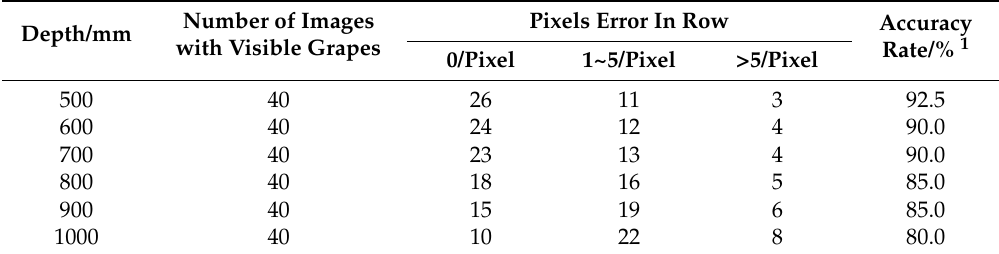
Table 4. Accuracy of picking-point